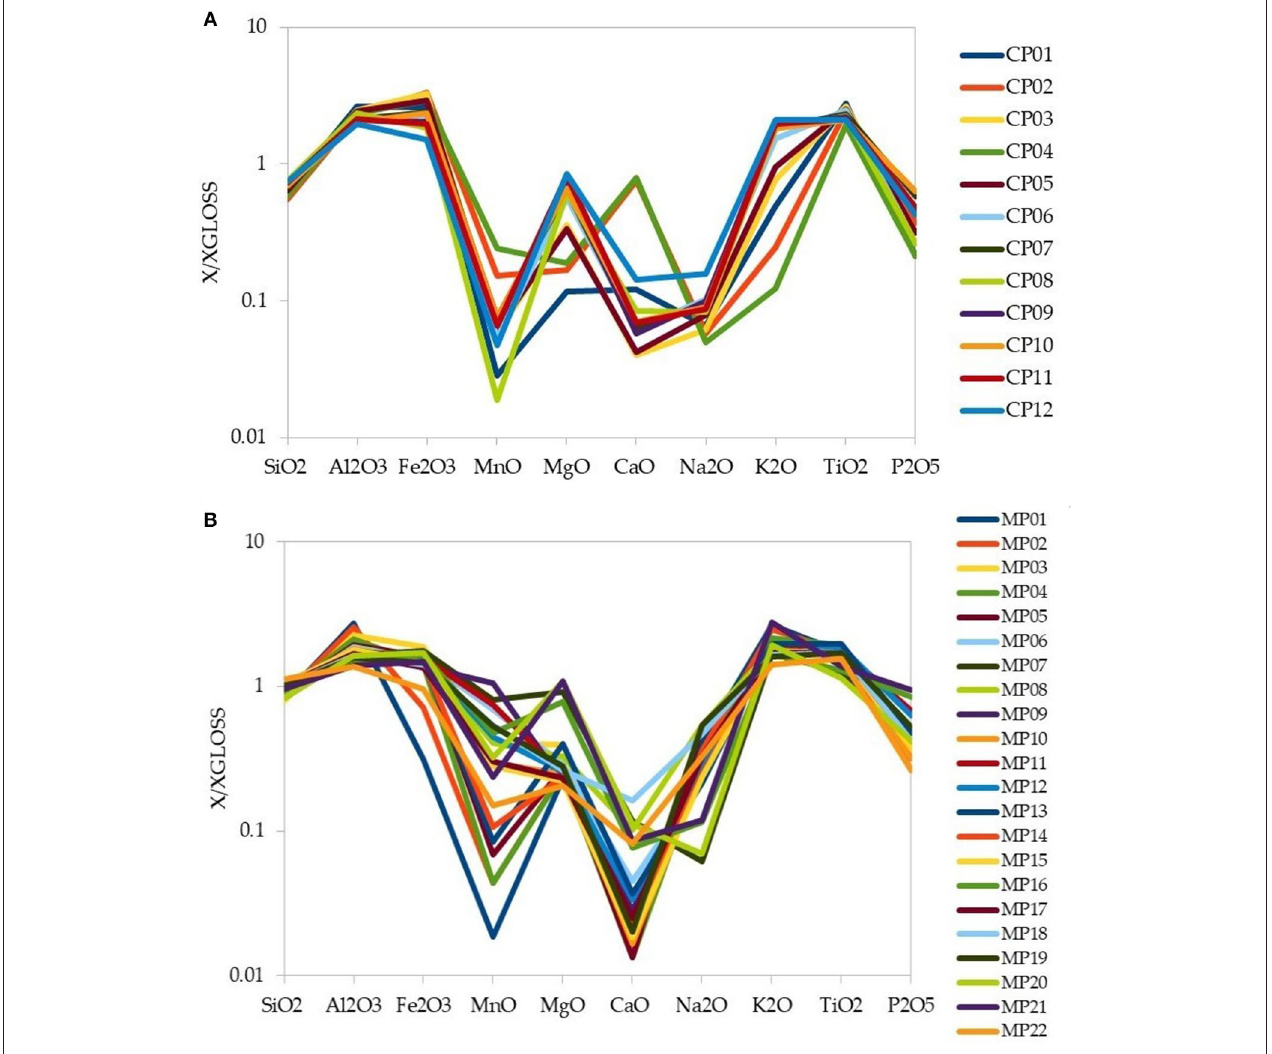
FIGURE 7 | Global Subducting Sediment (GLOSS)-normalized major elements patterns of (A) the CP palaeosols, and (B) the MP palaeosols. GLOSS values are from Plank and Langmuir (1998).